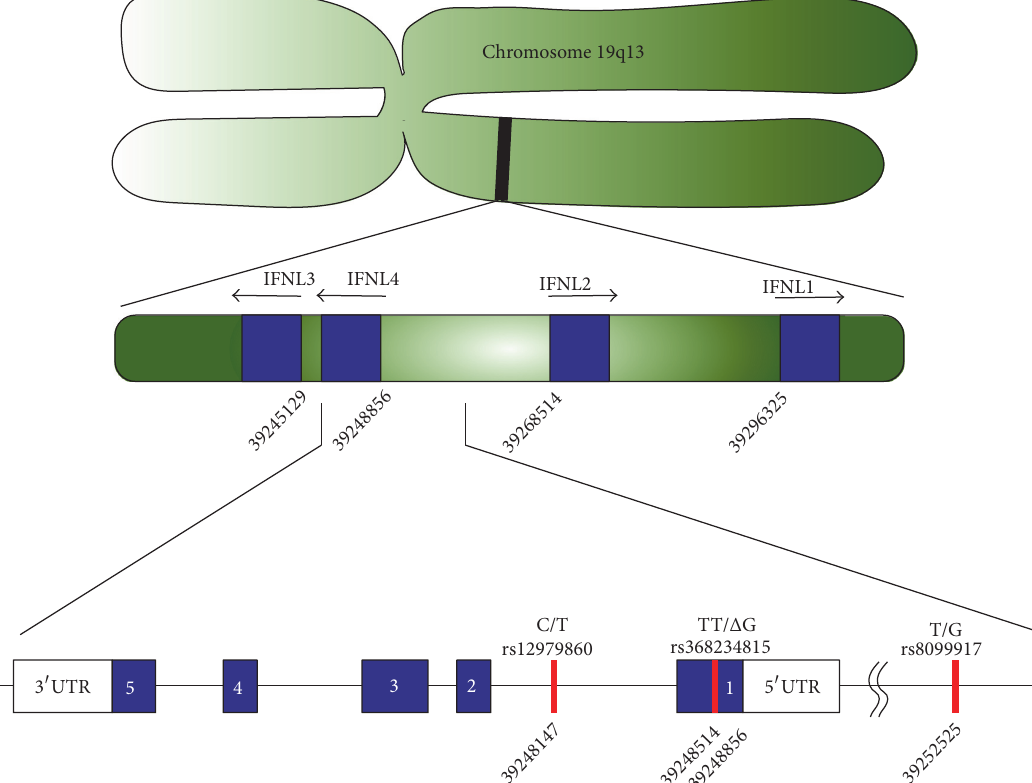
Figure 4: Schematic representation of the IFNL chromosome locus. Depicted is the position and orientation of the genes for IFNL1–4 (blue) on chromosome 19 q13 (green). The numbers below the genes display the nucleotide position of the first exon of each IFNL subtype. IFNL1-2 are located on the forward strand of the chromosome, while IFNL3-4 are located on the reverse strand. The genetic organization of IFNL4 is shown in more detail; it consists of five exons (blue) and 3 󸀠 /5 󸀠 untranslated regions (UTR). Single nucleotide polymorphisms rs12979860, rs368234815, and rs8099917 and their corresponding nucleotide position are indicated (red). Adapted from [38,